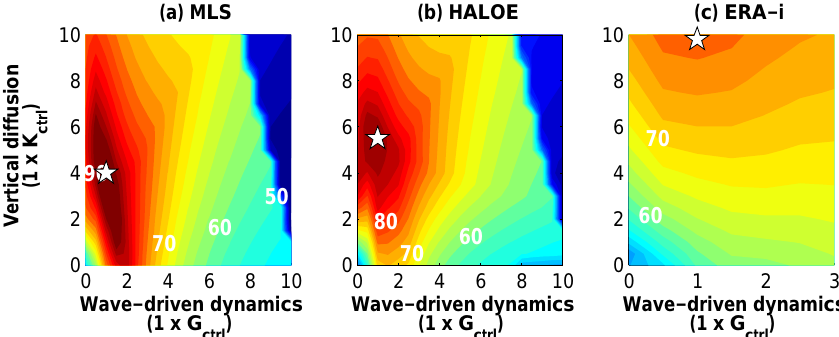
Figure 5. The percentage total scores (see text for details) of the synthetic MLS (a) , HALOE (b) , and ERA-i (c) tape recorders at 80hPa. The white stars mark the combinations producing the highest scores.